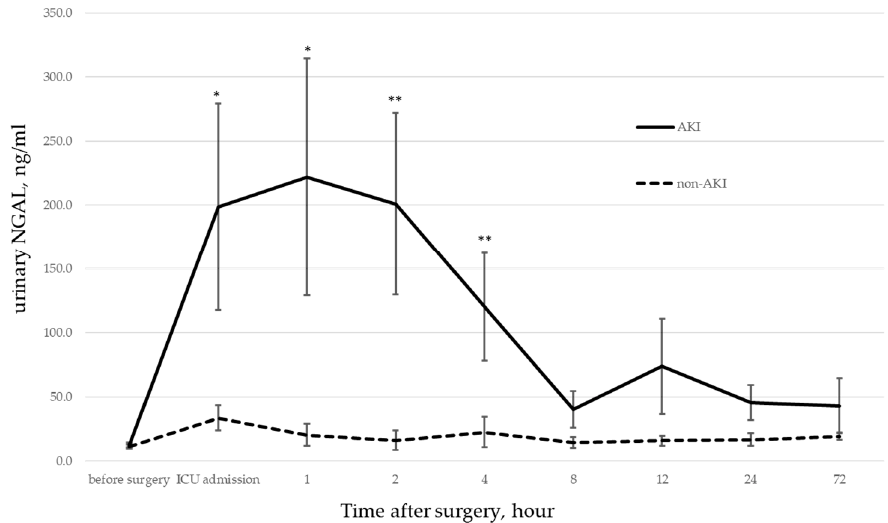
Figure 1. AKI vs. non-AKI NGAL. Changes in urinary NGAL in the AKI and non-AKI groups. There was no significant difference before surgery, but a strong significant difference was shown from the time of admission to the time of intensive care unit (ICU) admission (0 h) and 2 h later ( p < 0.001 *), and the difference continued until 4 h later ( p < 0.05 **).